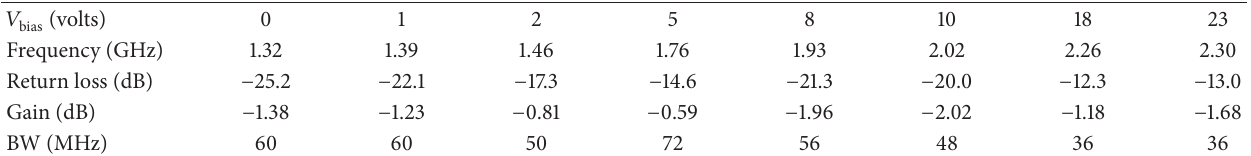
Figure 10: Measured 2-D radiation patterns of the tunable dual-band antenna with cross-type network and without cross-type network (eye-shaped antenna case): (a) 1.8 and (b) 3.5 GHz. Table 2: Performance of the tunable dual-band antenna with fixed 3.5 GHz, variable 𝐶 1 = 0.56 pF, 𝐶 2 = 0.68 pF, 𝐿 1 = 0.2 nH, 𝐿 2 = 6.8 nH, = 0.47 pF, and 𝐿 = 3.9 𝐶 4 3